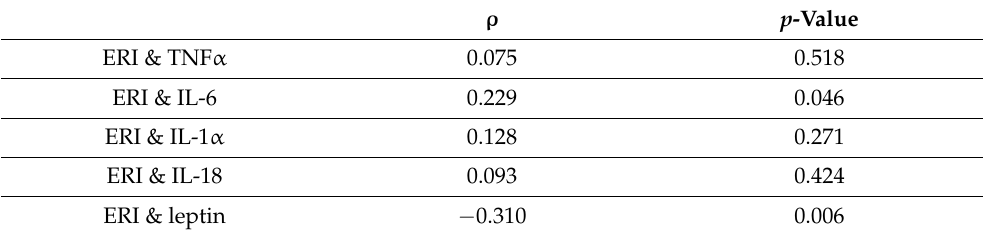
Table 8. Correlations of main cytokines in the study with ERI value.